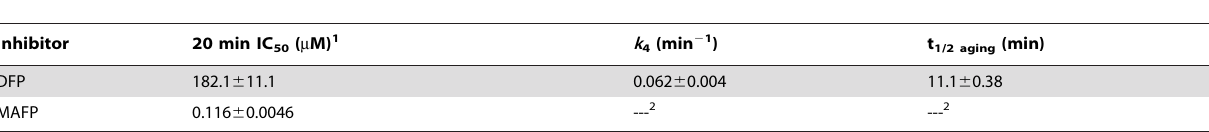
Table 1. Kinetics of inhibition and aging of DFP and MAFP against Pat17.